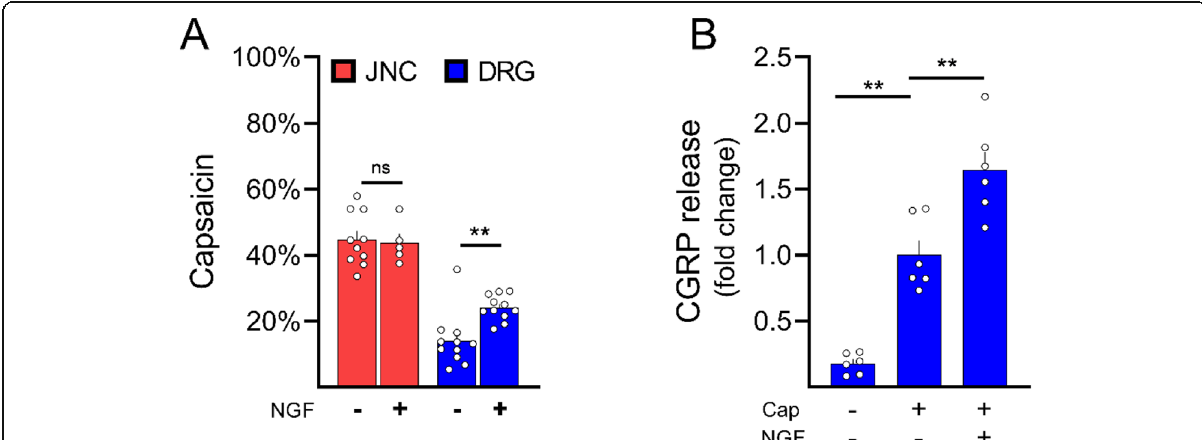
Fig. 3 JNC neurons are insensitive to NGF. Naïve C57BL/6 mouse JNC and DRG neurons were harvested, cultured for 24h in the presence of Nerve Growth Factor (NGF, 50 ng/mL). The cells were then loaded with a calcium responsive dye (Fura-2AM) and sequentially exposed to capsaicin (100 nM) followed by KCl (40mM; positive control; A) . The addition of NGF increased the number of capsaicin-responsive neurons in DRG cultures but not in the one from the JNC ( A ). Similarly, NGF increased capsaicin-induced CGRP release from cultured DRG neurons (B) . Data are shown as mean ± S.E.M. Number of dishes tested is shown. N are as follows: A : n=5-10 dishes/group from two independent experiments , B : n=6 wells from different animals/group from two independent experiments. P-values are shown in the figure and determined by unpaired Student's t-test ( A ) or one-way ANOVA post hoc Dunnett ( B